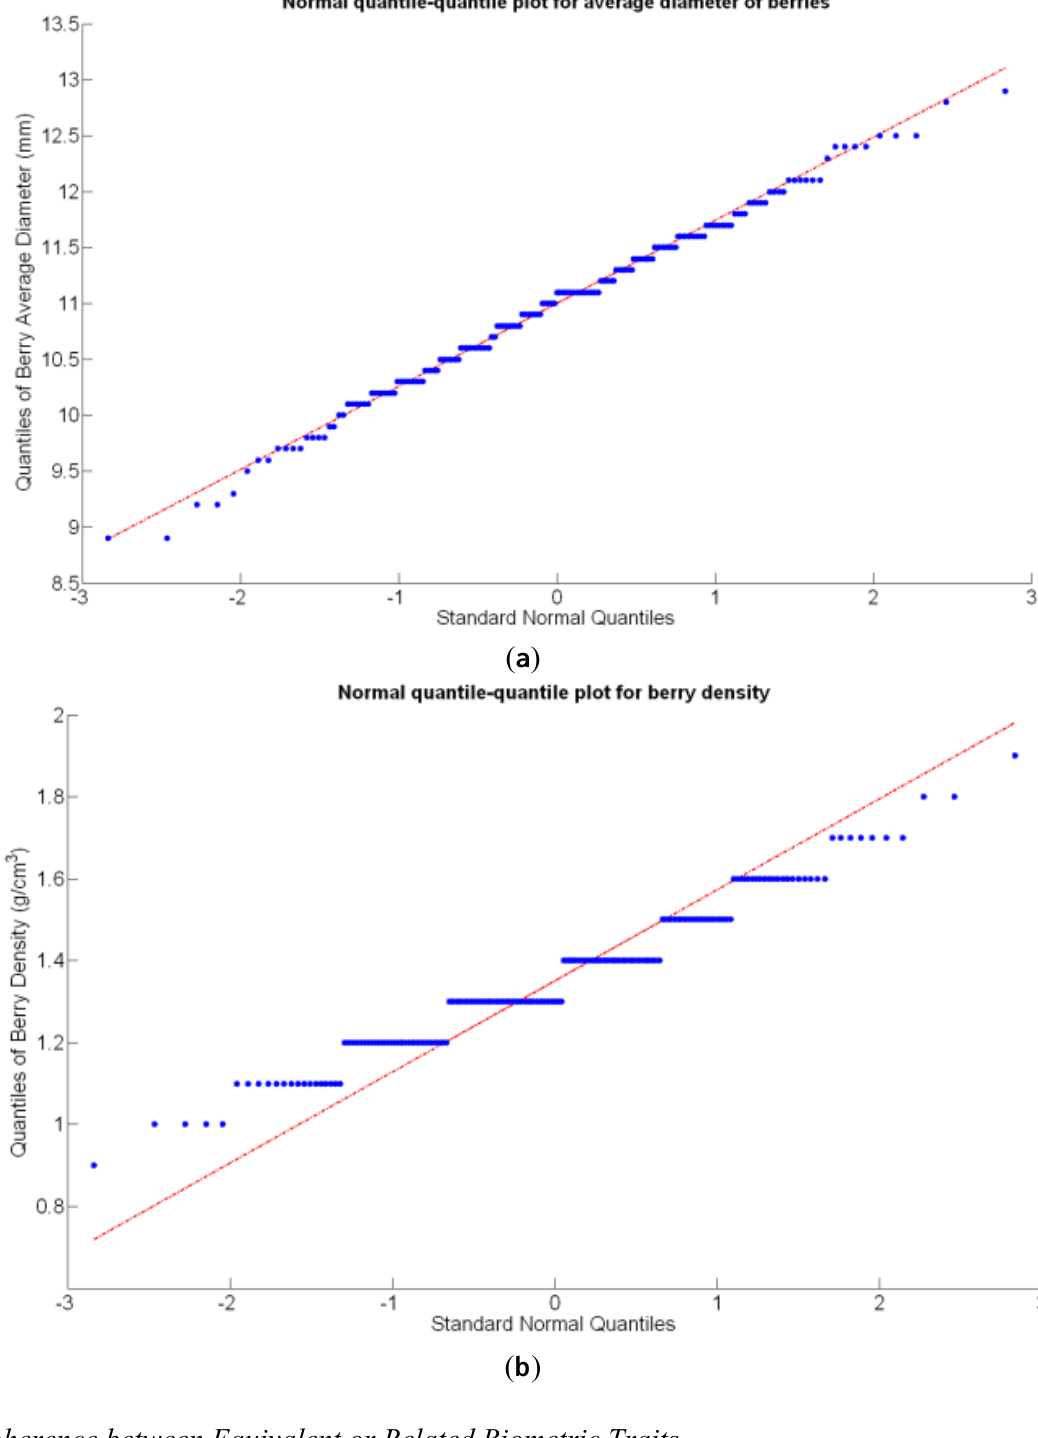
Figure 21. Normal quantile-quantile plots: ( a ) Berry average diameter (mm); ( b ) Berry density (g/cm 3